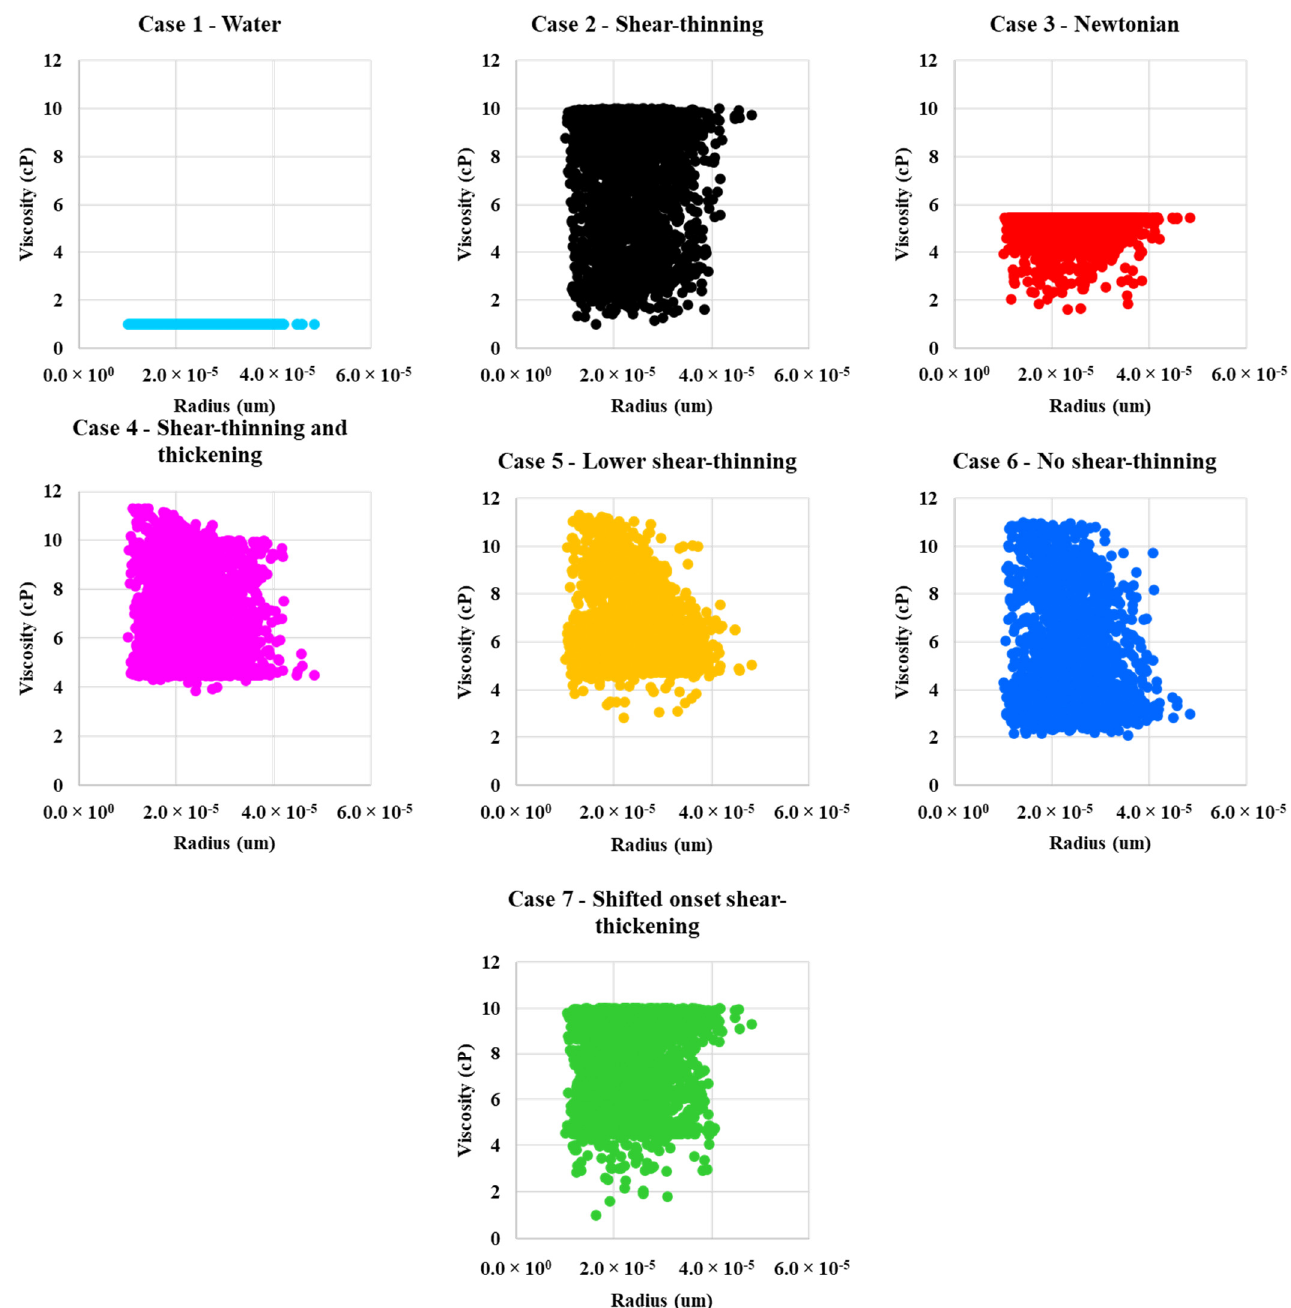
Figure 9. In-situ viscosity as a function of radius for case 1—water, case 2—shear-thinning, case 3—Newtonian, case 4—shear-thinning and thickening, case 5—lower shear-thinning, case 6—no shear-thinning, and case 7—shifted onset of shear-thickening polymer.